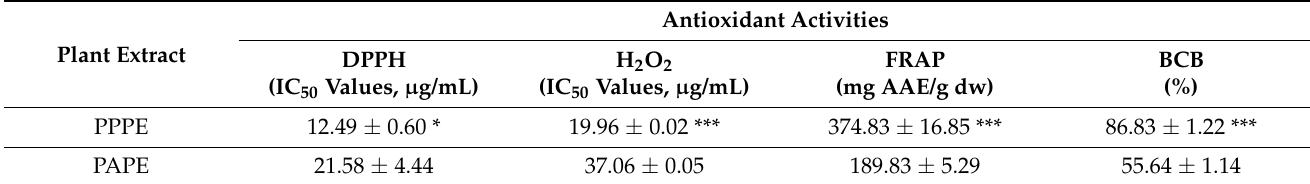
Table 2. Antioxidant activities of PPPE and PAPE. Results are expressed as the mean ± sem of at least three independent assays of each sample. * p < 0.05 and *** p < 0.001 indicate significant differences compared to the control.